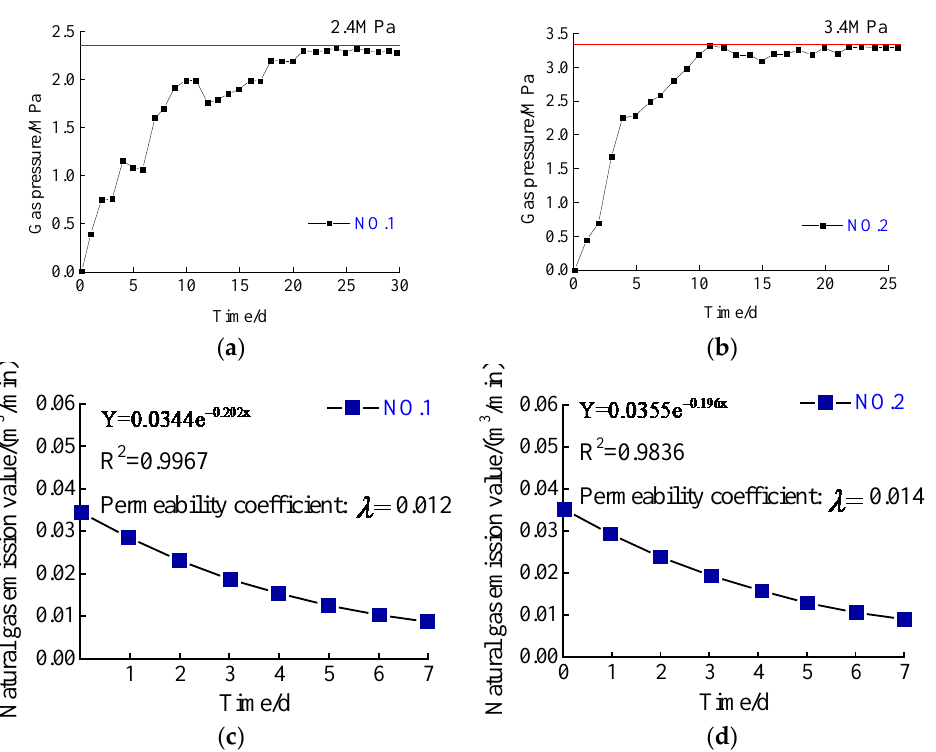
Figure 4. Original area of group Ji coal seam: ( a ) NO. 1 measuring point gas pressure test data; ( b ) NO. 2 measuring gas pressure point test data; ( c ) NO. 1 measuring point permeability coefficient test data; ( d ) NO. 2 measuring point permeability coefficient test data.